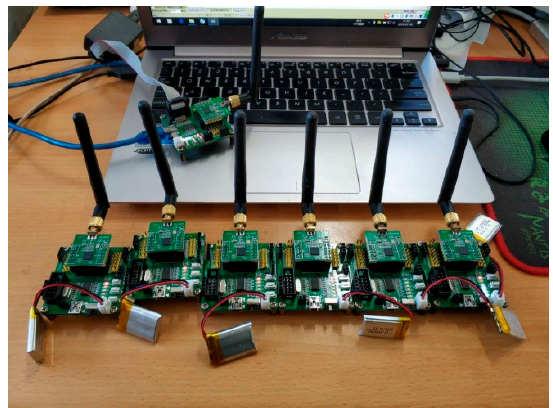
Figure 8. The diagram of the experimental environment. Table 1. Experiment